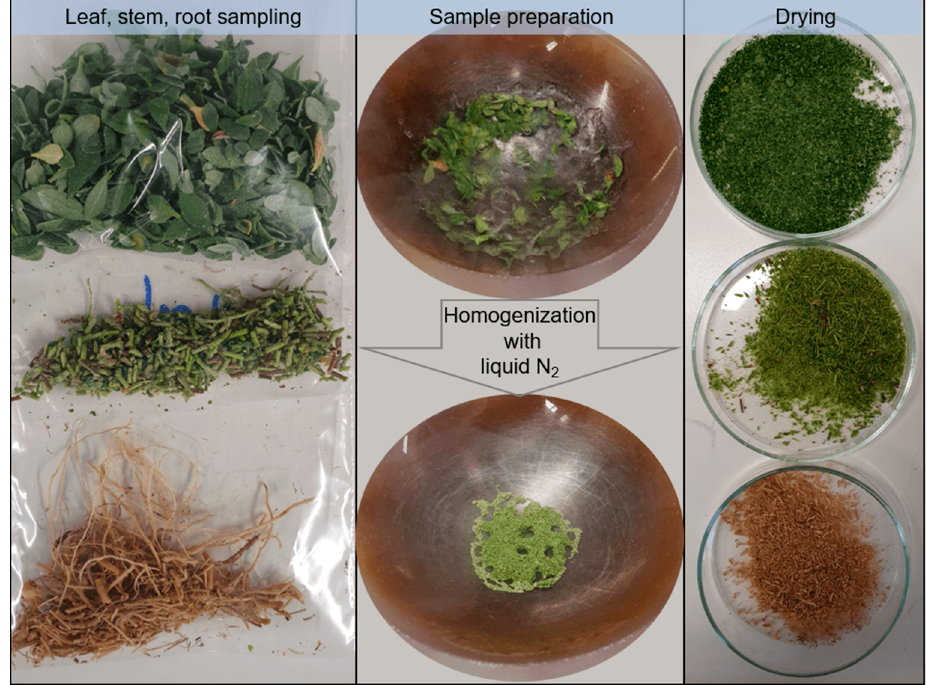
Figure 5. Sample preparation workflow of leaves, stems, and roots of A. murale prior to microwave digestion for ICP-OES measurements. The homogenization of leaves is shown exemplarily.